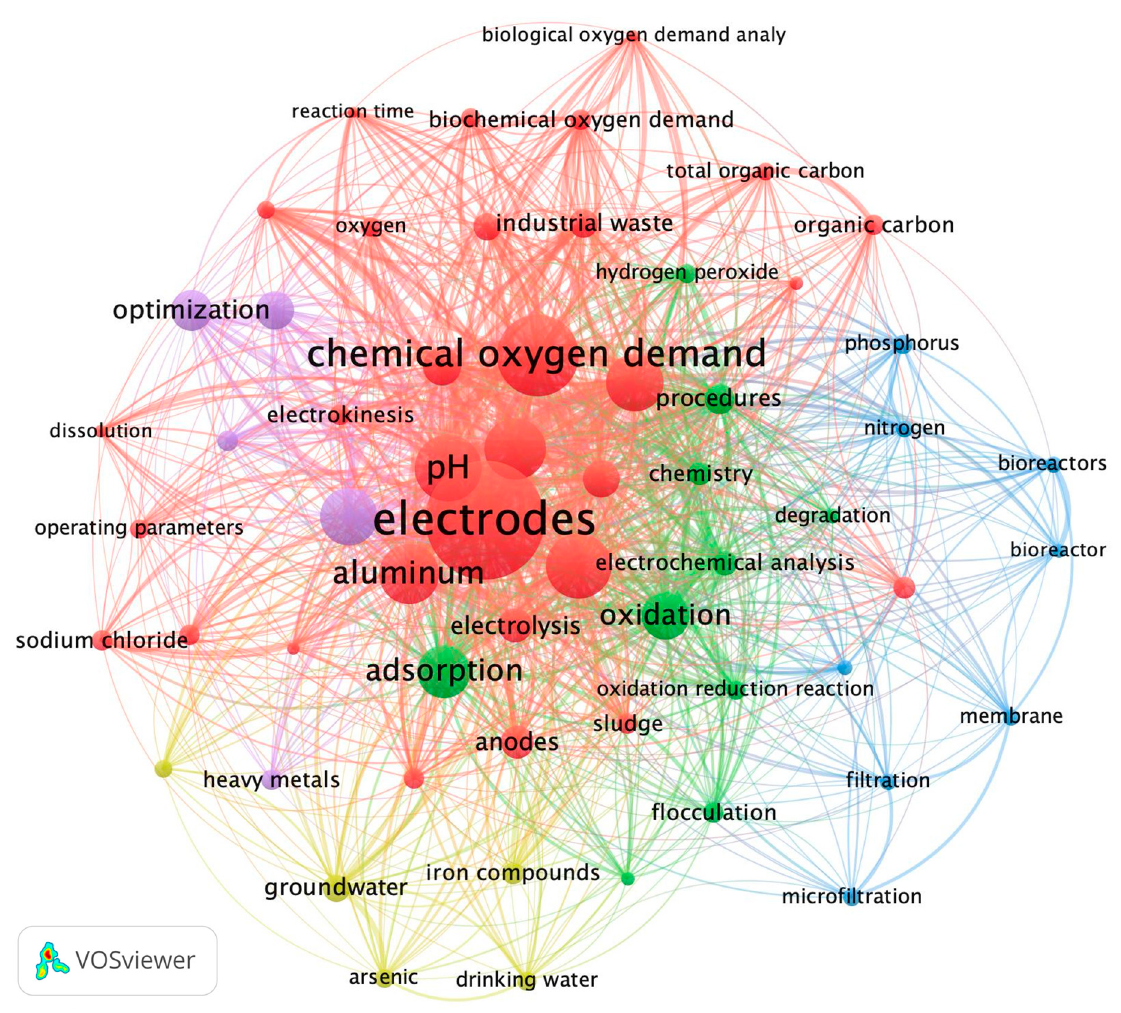
Figure 4. Key terms occurrences network visualization map in a study of EC from 2018 to 2022.